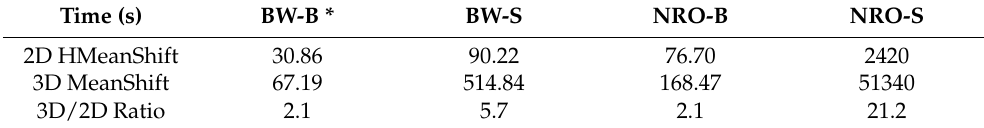
Table 5. Comparison of the computing efficiency between 2D HMeanShift (SA) and 3D MeanShift. Time (s) 2D